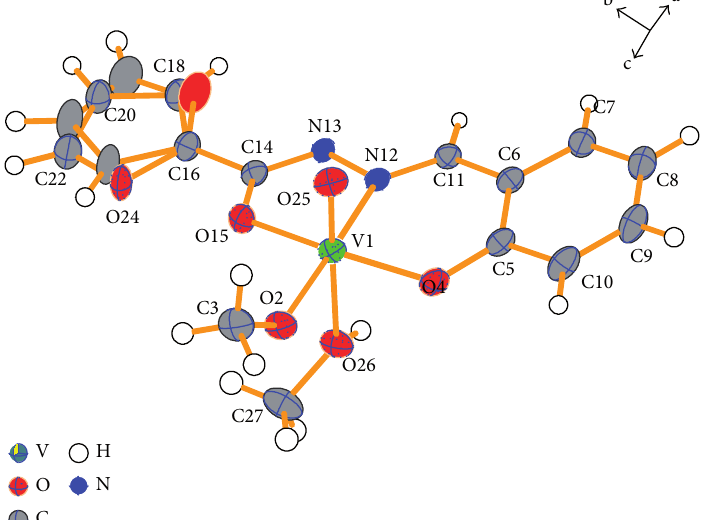
F 2: ermal ellipsoid plot of [VO(L probability level, bond lengths and angles in Table